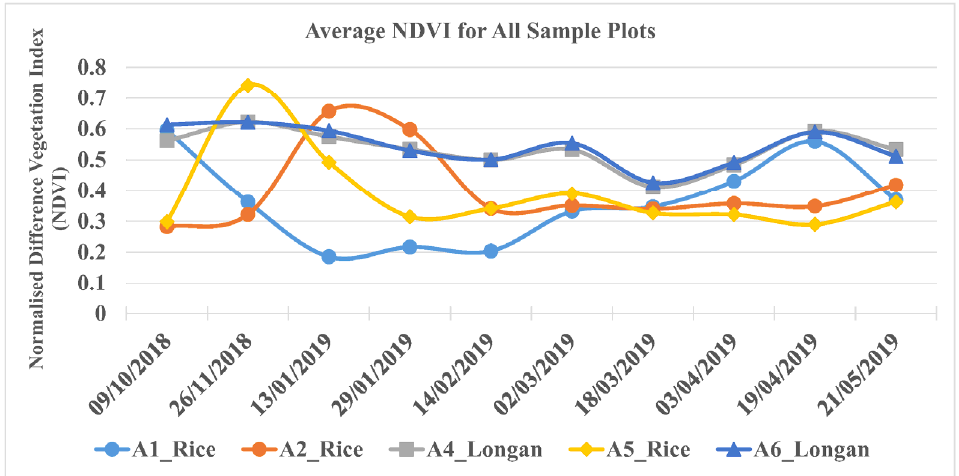
Figure 3. Crop phenology for plots in the testing area located in the Chom Thong District, Chiang Mai Province, downstream of the Muang Luang Weir in Thailand based on the Normalised Difference Vegetation Index (NDVI) in the dry season.